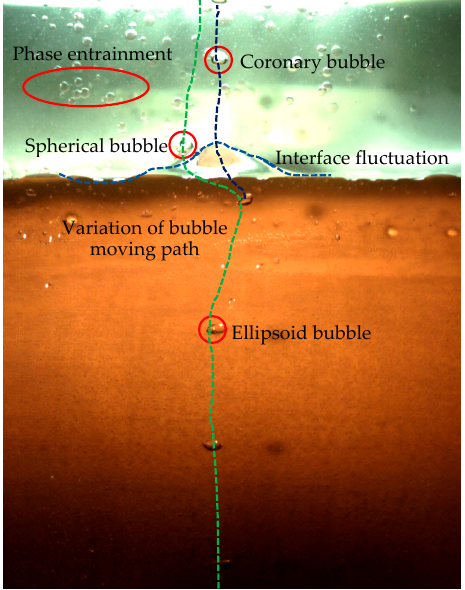
Figure 3. Bubble shape, movement path, and interfluctuation.